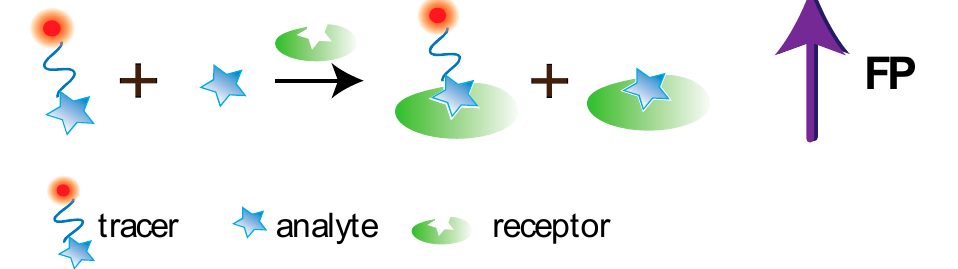
Figure 2. Principle of conventional FPIA.